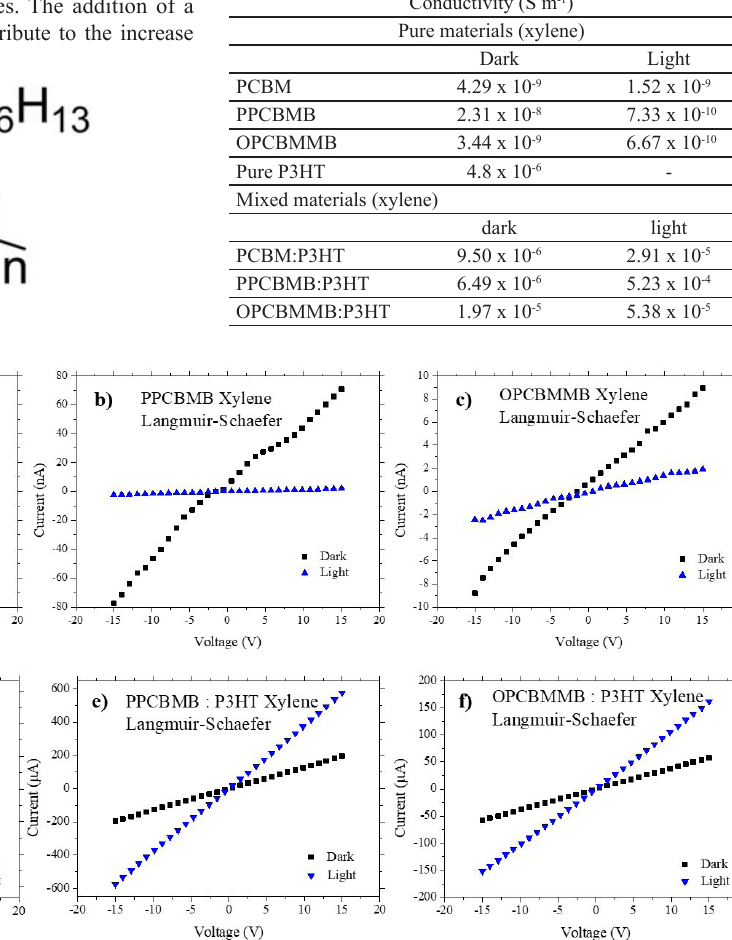
Table 1. Conductivity values for full and mixed pure and mixed poly(fullerene)s solubilized with xylene. Conductivity (S m -1